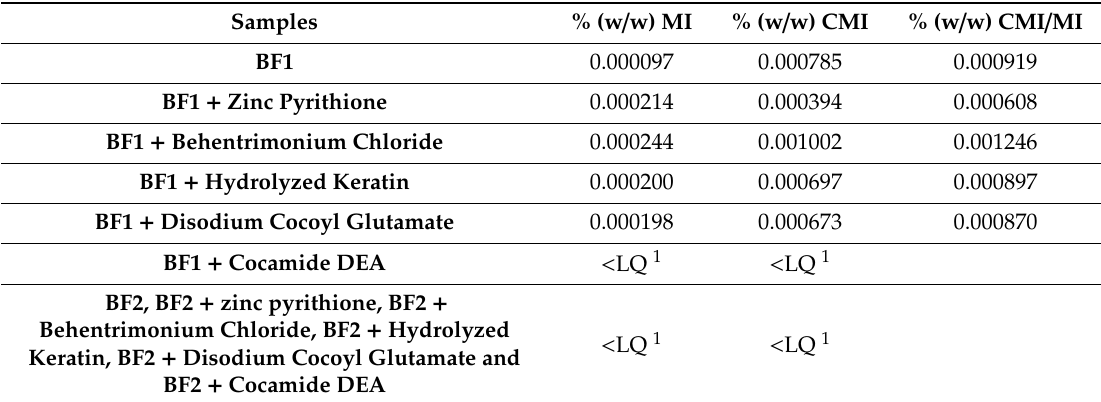
Table 4. Quantification of the preservative 3 days after